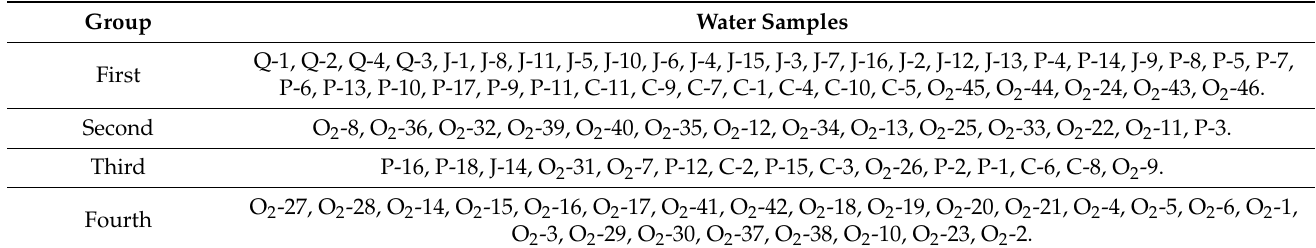
Figure 3. Cluster analysis pedigree: ( a ) Q cluster analysis; ( b ) R cluster analysis. Table 3. Q Cluster Analysis Results.